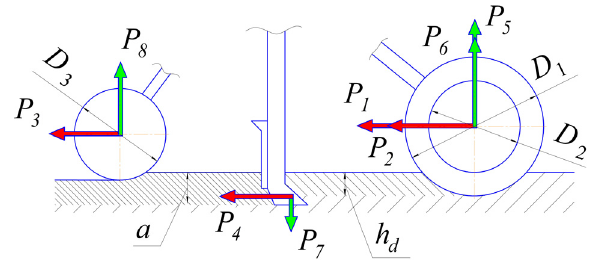
Figure 2. Components of the tractive resistance of the sowing